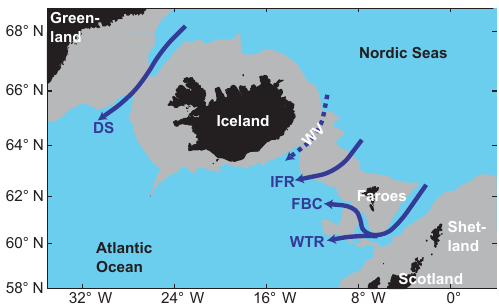
Figure 1. The Greenland–Scotland region (grey areas are shal- lower than 750m) with the four traditional overflow branches in- dicated by blue arrows that pass through the Denmark Strait (DS), through the Faroe Bank Channel (FBC), across the Wyville Thom- son Ridge (WTR) and across the Iceland–Faroe Ridge (IFR). The focus of this study is on the overflow through the Western Val- ley (WV) indicated by a hatched blue arrow, which is a component of